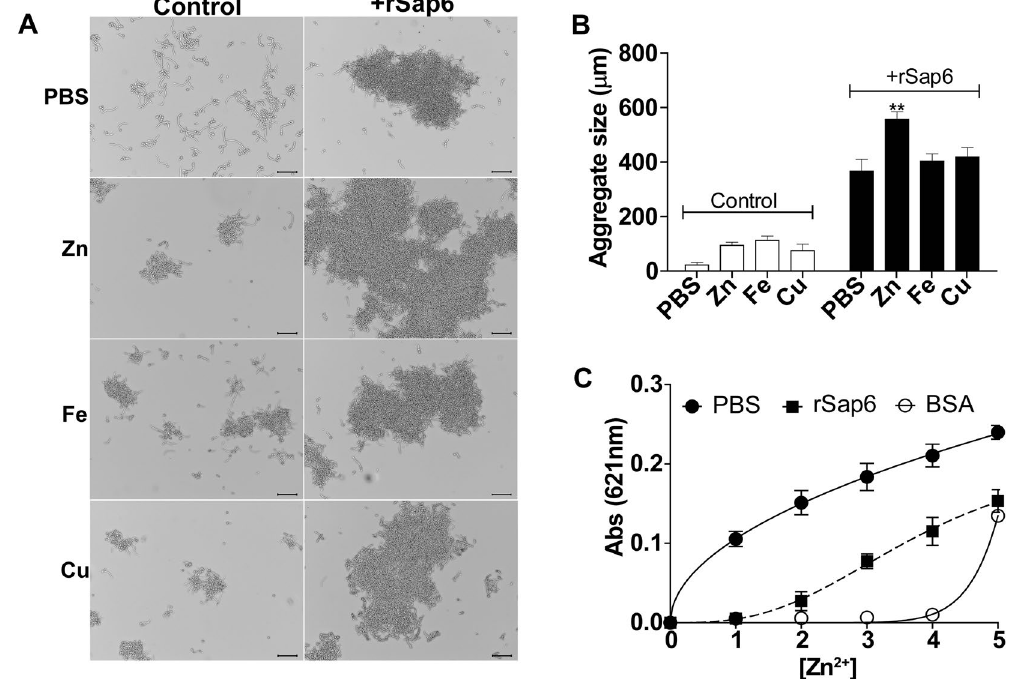
Figure 1. Sap6 preferably interacts with zinc to increase cellular adhesion. ( A ) Wild type (WT) cells were germinated for 3 h at 37 °C and then incubated either with metal alone or metal pre-incubated with rSap6 for 15 min and observed microscopically. Addition of ZnCl 2 (10 µ M), FeCl 3 (10 µ M) and CuSO 4 (10 µ M) as metal control induced small aggregates compared to PBS. The aggregates were observed and documented at 10X. ( B ) ImageJ software was used to analyze aggregate size. Germinated cells incubated with metal control (ZnCl 2 , FeCl 3 and CuSO 4 ) induced aggregation compared to PBS (white bars). The aggregate size after addition of Zn- rSap6 complex was significantly increased whereas there was no significant change in aggregate size after adding Fe or Cu-rSap6 complex (black bars). The bars show mean ± SD of at least three independent experiments. The P-value was ≤ 0.01 and was calculated using one-way ANOVA. ( C ) Zincon (20 µ M) (PBS) alone, or Zincon mixed with rSap6 or bovine serum albumin (BSA) (2:1) in 75 mM HEPES, 100 mM NaCl, pH 7.4 were titrated against Zn 2 + . Addition of one to five equivalents of Zn 2 + proportionally decreased absorbance in Zincon + Sap6 suggesting up to five Zn 2 + affinity sites in Sap6; while BSA served as positive control and showed a minimum of four zinc binding sites. Measurements were performed at three independent time points in triplicate and the mean ± SD are